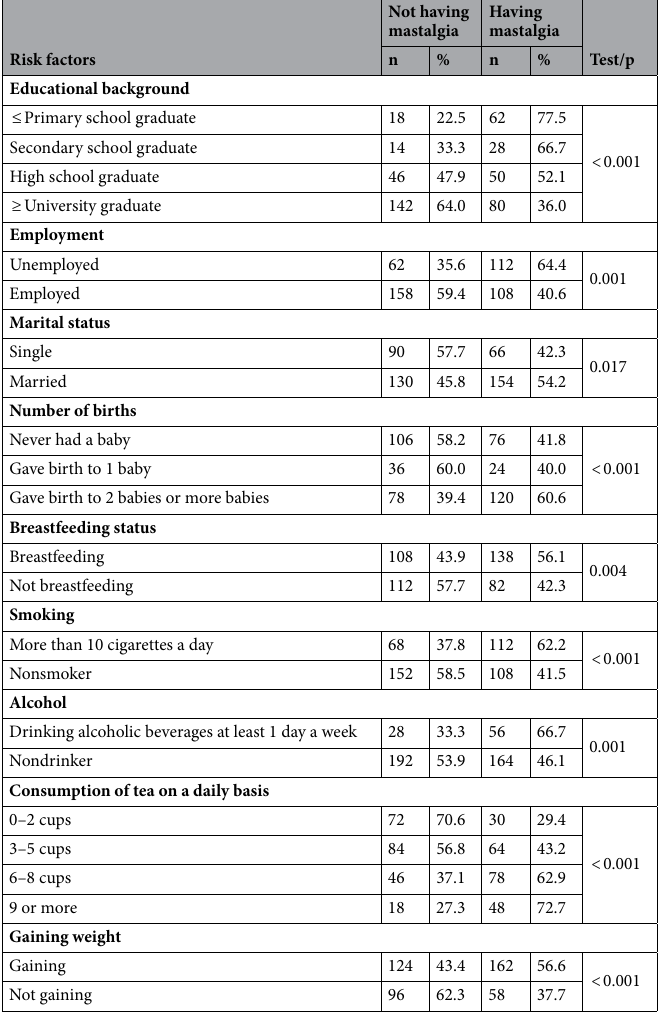
Table 3. Distribution of certain variables in groups with and without mastalgia. Pearson chi-square test was used. n